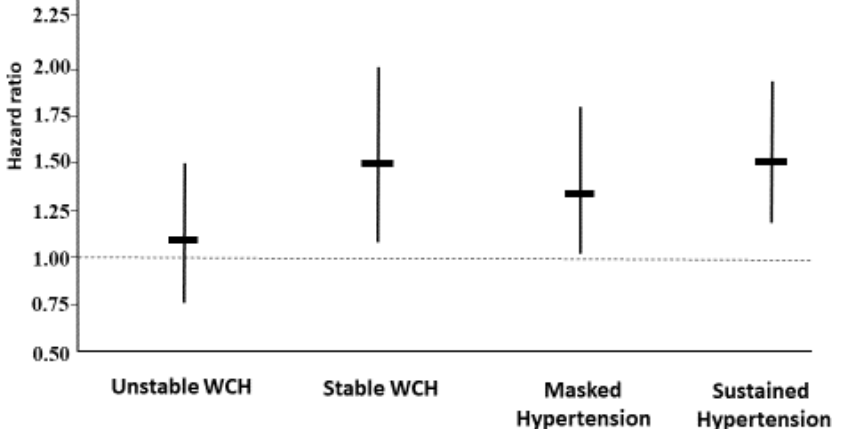
Figure 2. Long-term risk of established hypertension in the participants stratified according to their BP status assessed three months after enrolment. Hazard ratios and 95% confidence intervals were derived from a multivariable Cox regression model. The normotensive group was taken as the reference. WCH indicates white-coat hypertension.